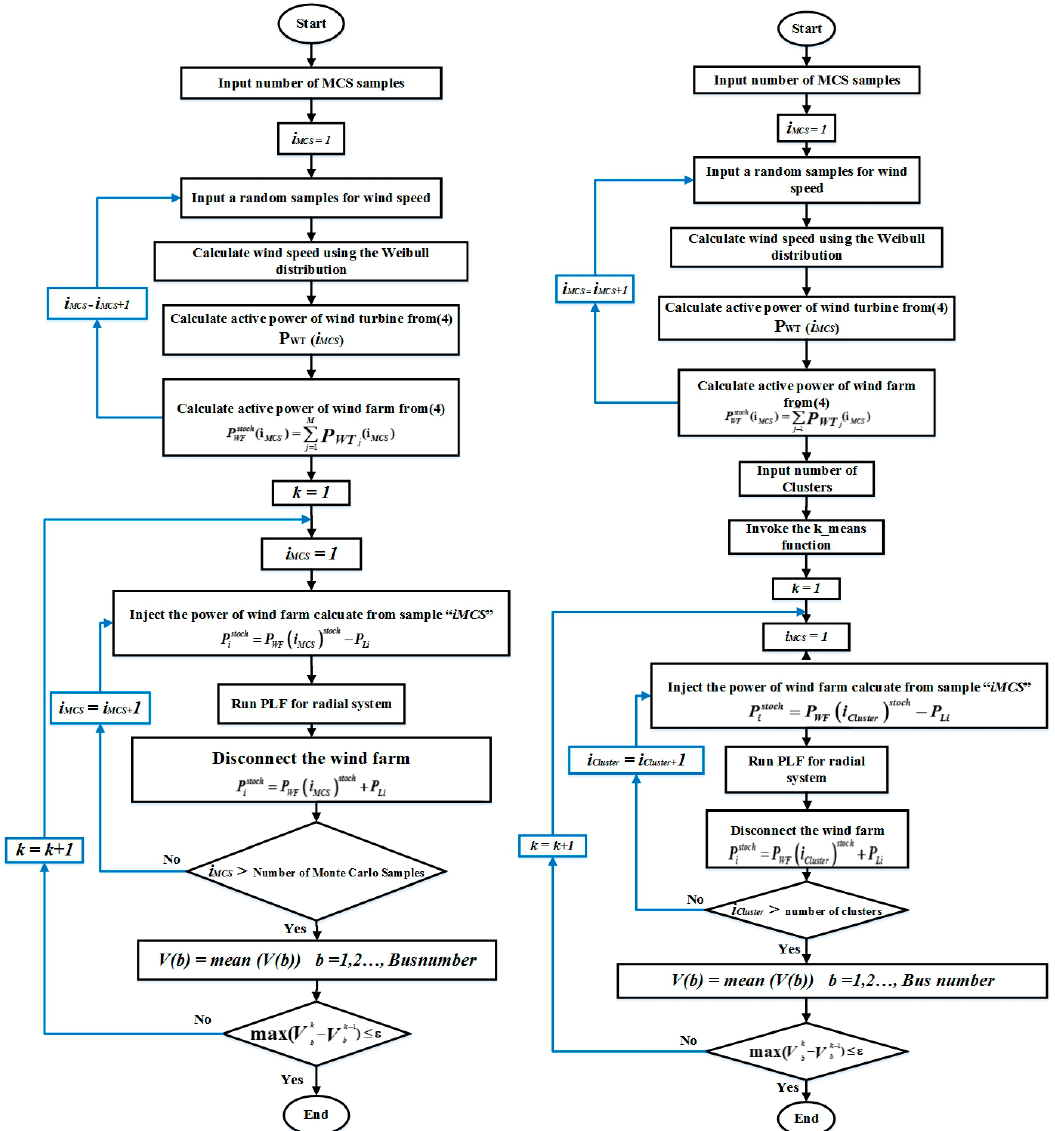
Figure 2. Flowcharts of the proposed direct probabilistic load flow (PLF), ( a ) unsorted data, and ( b ) K-means data